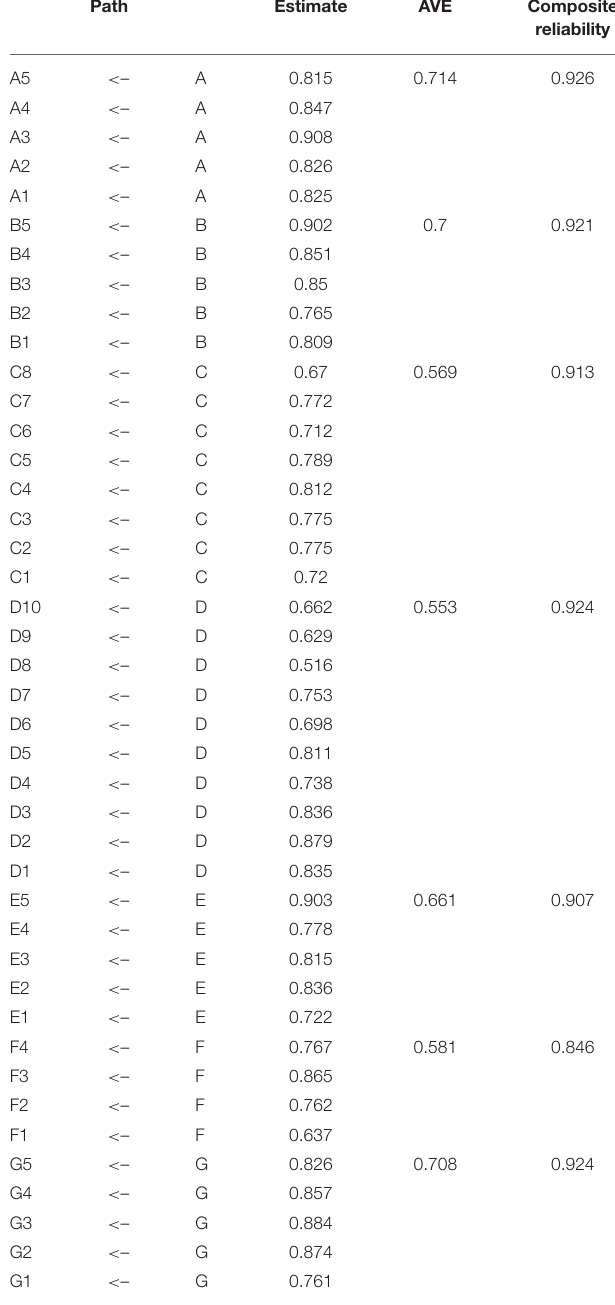
TABLE 2 | Factor loading analysis